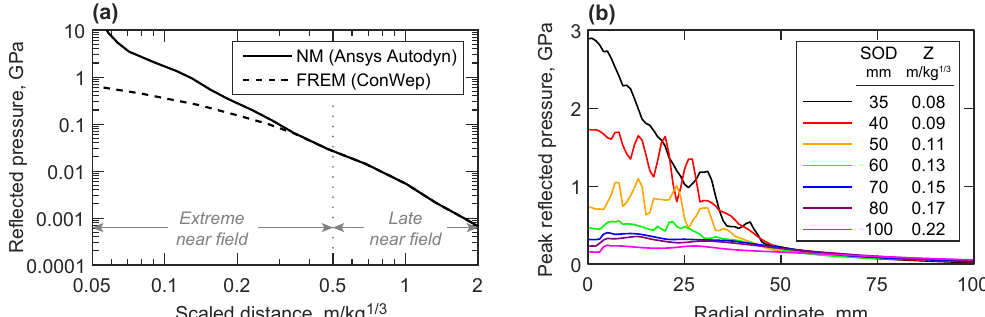
Figure 1. Predictions of near-field reflected overpressures. ( a ) The large discrepancy in the predictions made by numerical models such as Ansys Autodyn [10] and fast-running engineering models such as ConWep [9] in the extreme near field. ( b ) Numerical predictions for the peak reflected overpressure with radial ordinate on a rigid reflecting plate, resulting from a 100 g spherical charge of PE-4 at various stand-off